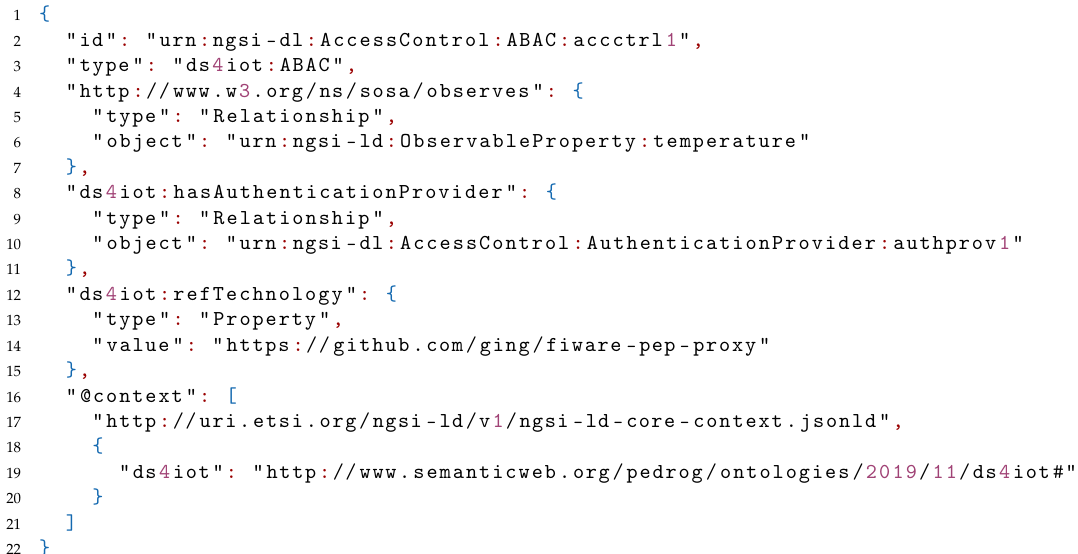
JavaScript Object Notation for Linked Data (JSON-LD) example representing an AccessControl